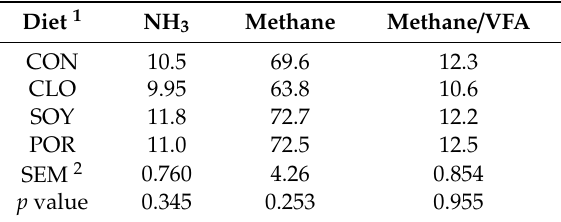
Table 4. Average values of NH 3 –N concentrations (mg / 100 mL), production of methane (mL / g DM), and methane / total volatile fatty acids (methane / VFA mol / mol) ratios after 24 h of incubation of the experimental diets in batch cultures inoculated with ruminal microorganisms from sheep.